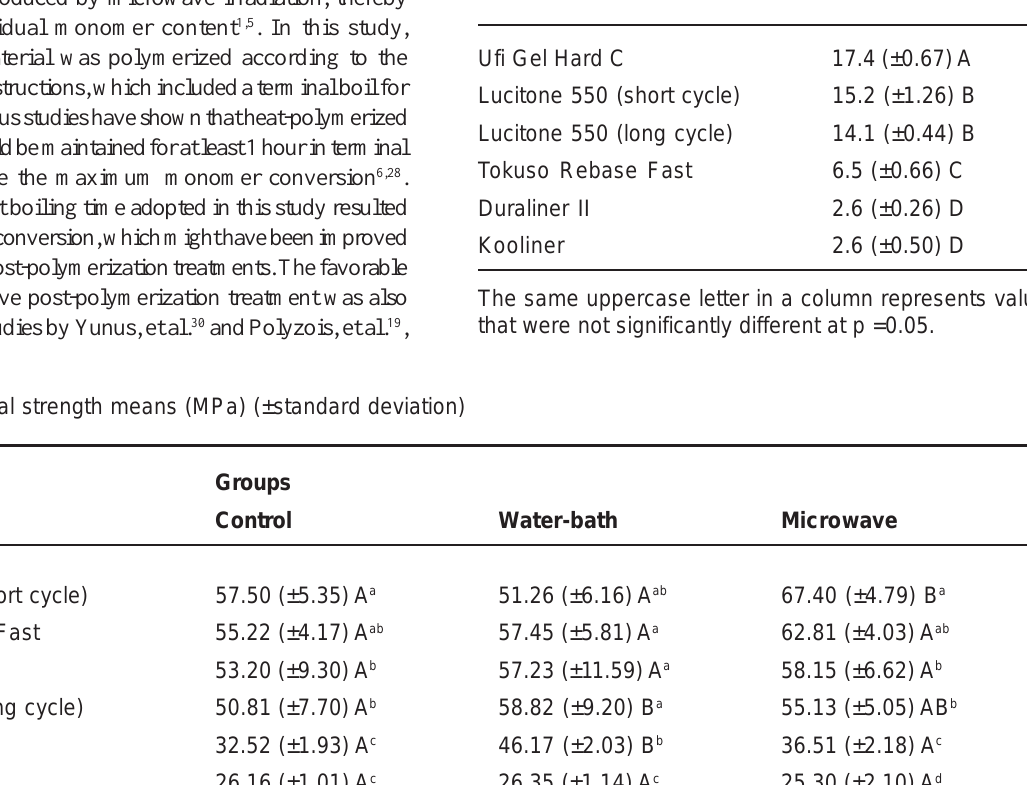
Within each line, entries with the same uppercase letter were not significantly different (p=0.05). The same superscript letter in a column represents values that were not significantly different at p